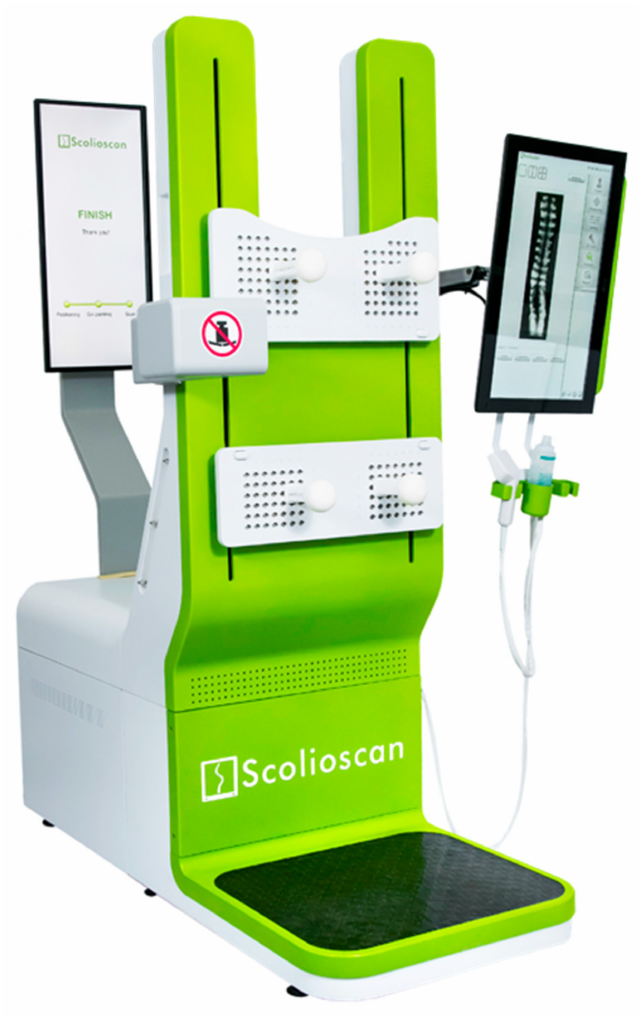
Figure 9. Scolioscan system